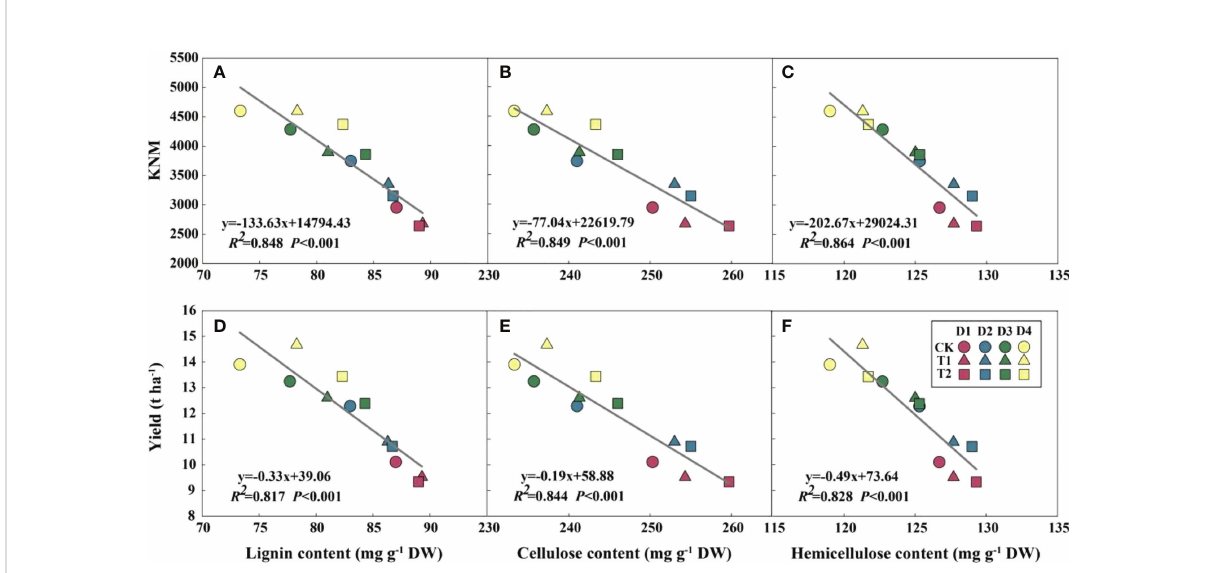
FIGURE 8 Relationships between structural carbohydrates with kernel number m -2 (KNM) (A – C) and grain yield (D – F) in 2021 ( n = 12 ). R 2 indicates the coef fi cient of determination. R 2 > 0.4 and P < 0.05 indicate a signi fi cant relationship. EC, plant growth regulator; PD, plant density; D1, D2, D3, and D4 indicated plant density at 4.5, 6.0, 7.5, and 9.0 plants m − 2 , respectively; CK, T1, and T2 indicated water control, 2 mL L − 1 EC (ethephon: cycocel = 3:1), 4 mL L − 1 EC, respectively. The data used for the regression analysis are the mean values under each